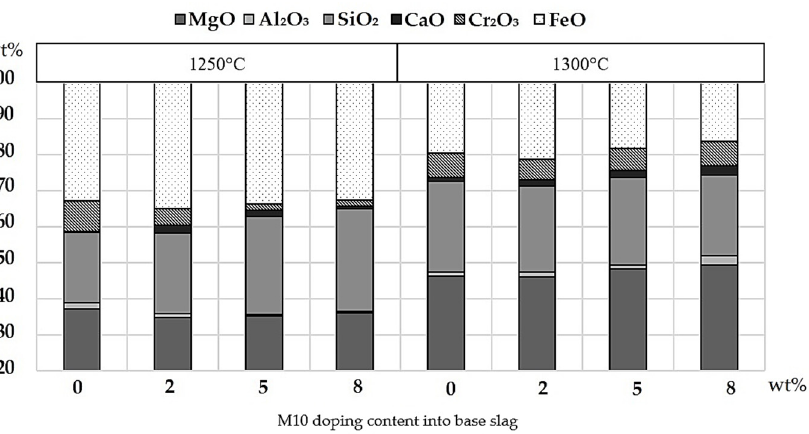
Figure 5. Infiltrated slag composition determined by SEM-EDS v/s montmorillonite K10 (M10) doping into base slag at 1250 and 1300 °C.